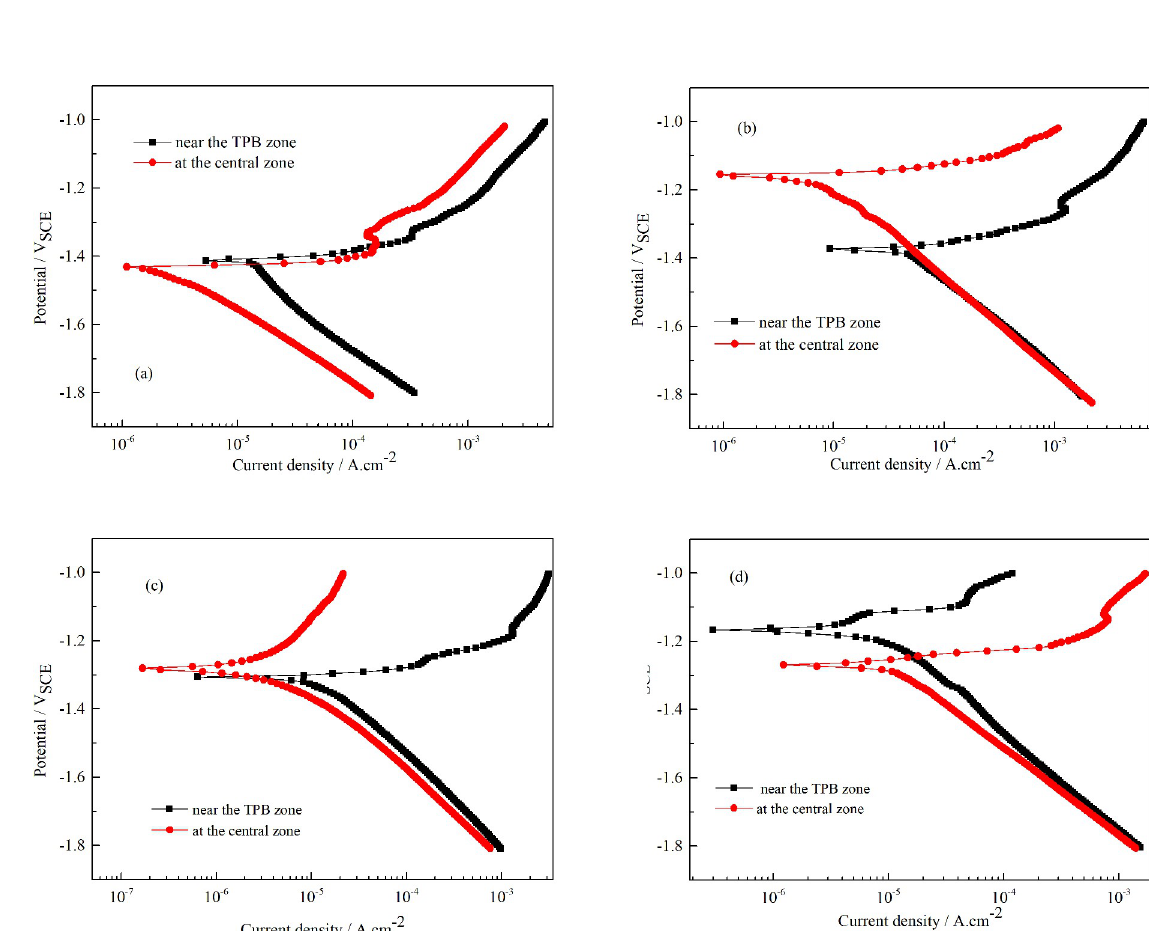
Fig 4. Typical polarization curves of AZ91D alloy under TEL for different times. a: 45 min, b: 3 h, c: 6 h, d: 12 h.